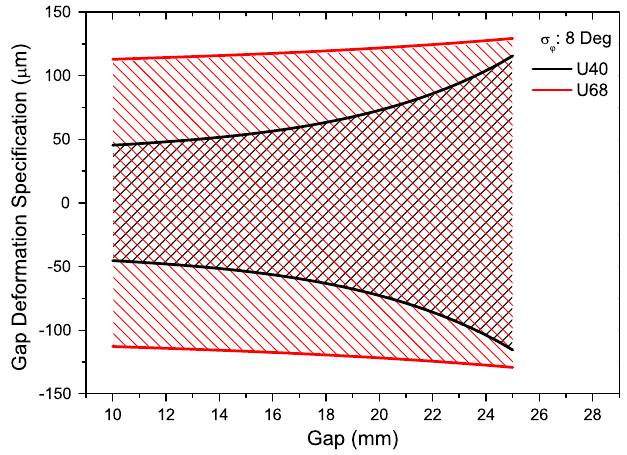
FIG. 6. Specification window for gap deformation for U40 (black) and U68 (red) undulators. The rms phase jitter tolerance is